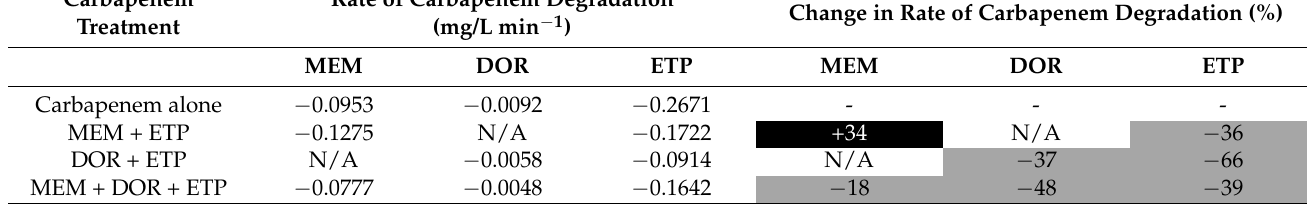
Table 4. Rate of degradation of MEM, DOR and ETP alone and in combinations in the presence of P. aeruginosa NCTC13437 in PBS at 37 ◦ C. Antibiotic concentration was measured using mass spectrometry. Rates of antibiotic degradation were calculated from the linear regression of the mean of two independent experiments showing the change in antibiotic concentration over 180 min at 37 ◦ C. Black shading = the rate of degradation of an antibiotic was increased in combination; grey shading = the rate of degradation of an antibiotic was decreased in combination. MEM—meropenem, DOR—doripenem,